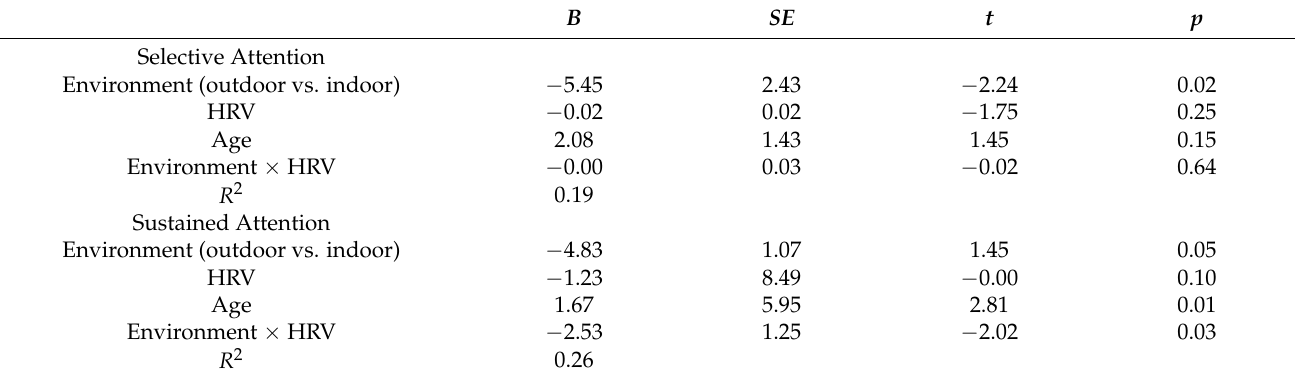
Table 2. Linear Regressions Models for Selective Attention and Sustained Attention. B